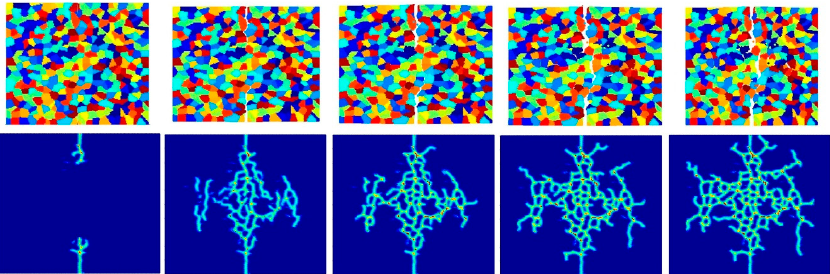
Figure 25. Fracture pattern of polycrystal when β = 0.5 with 400 grains in total. From left to right: time = 1.5 μ s, 2.0 μ s, 2.5 μ s, 3.0 μ s, and 3.5 μ s, respectively.